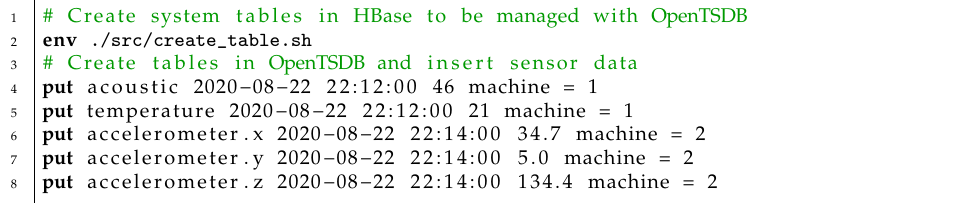
Figure 6. Create a sensor database in OpenTSDB (as an add-on over